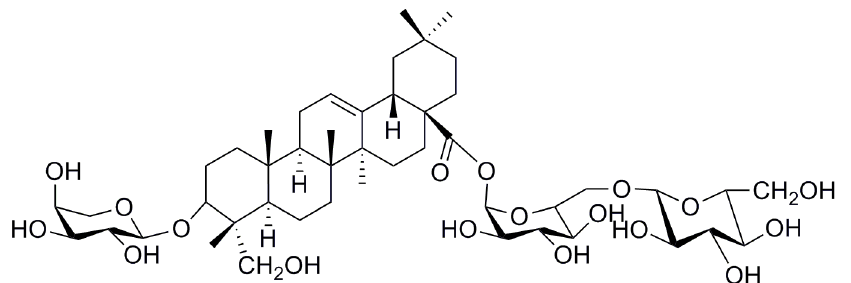
Figure 1. The chemical structure of